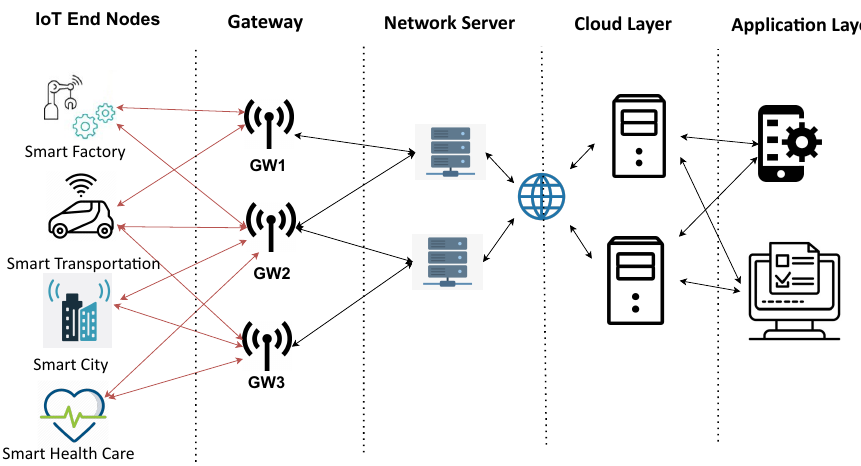
Figure 2. Cloud-based architecture.